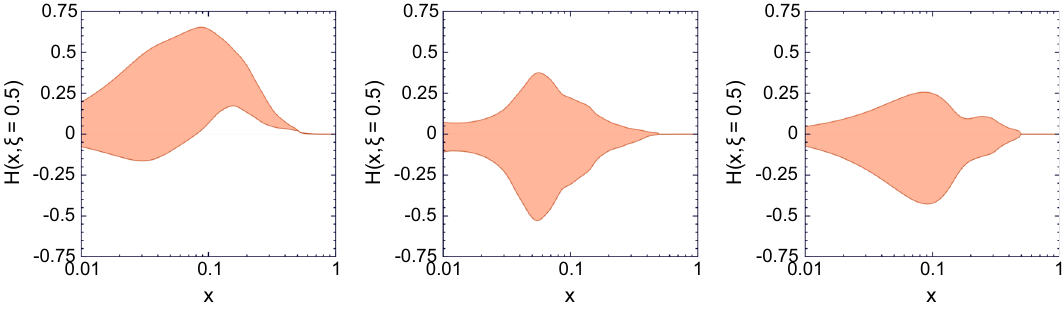
Fig. 9 Result of constraining the ANN model using 200 points eval- uated with the GK model [25–27] for sea quarks: x = ξ case, positiv- ity enforced. Contributions coming from (left) F C (β,α) and (center)